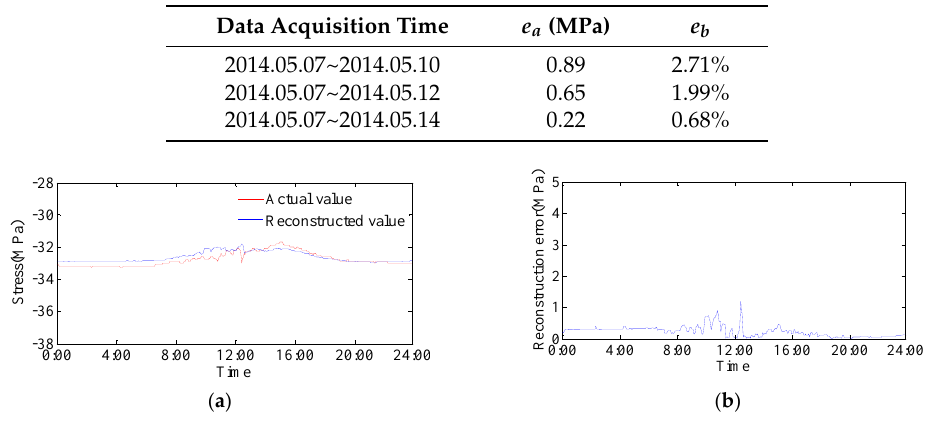
Figure 7. The reconstructed value and the actual value using data from 7 May 2014 to 12 May 2014: correlation model. This indicated that the larger quantity of stress monitoring data should be used, ( a ) the curve of reconstructed value and the actual value; and ( b ) the curve of reconstruction error. which is better for reconstruction of sensor measurements. In theory, the number of measurements Table 3. The summarized errors using stress monitoring data from different time periods.